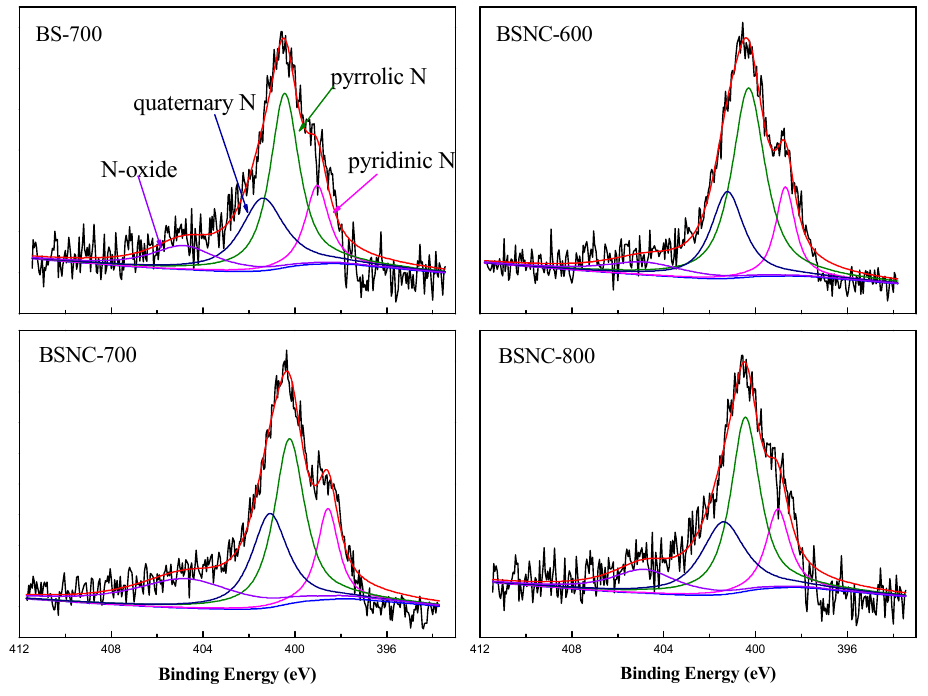
Figure 2. N1s spectra of the obtained carbons materials. Table 3. Relative amounts of nitrogen species of the N1s spectra.